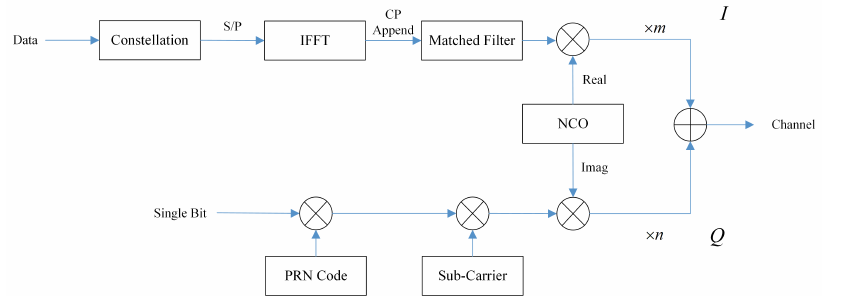
Figure 2. Block diagram of designed